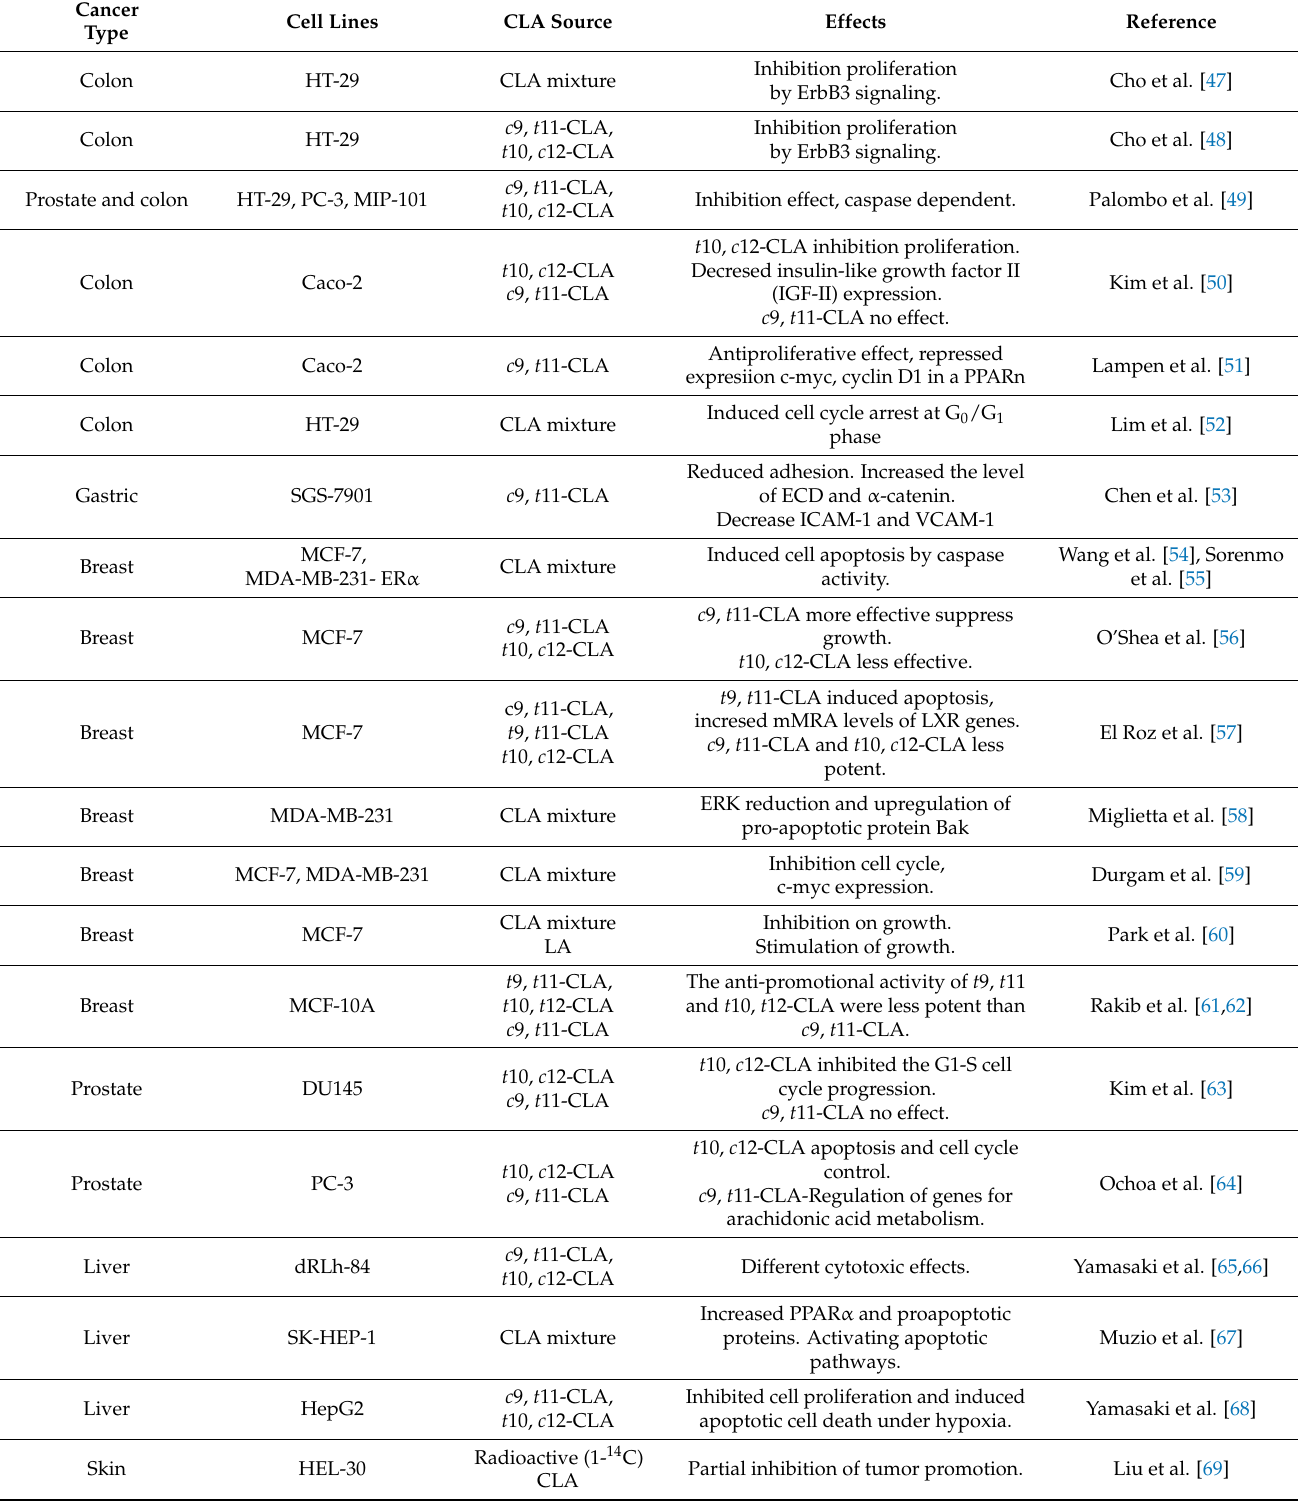
Table 2. Effects of CLA in carcinogenesis (cellular